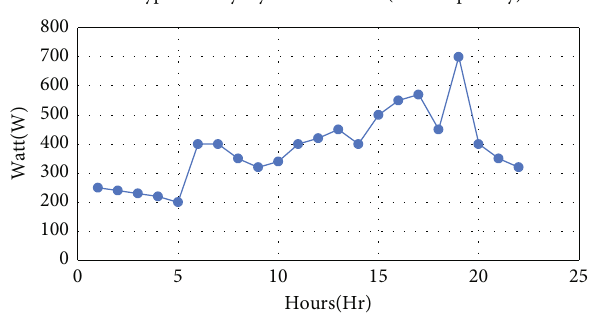
Figure 5: Typical everyday demand curve of a